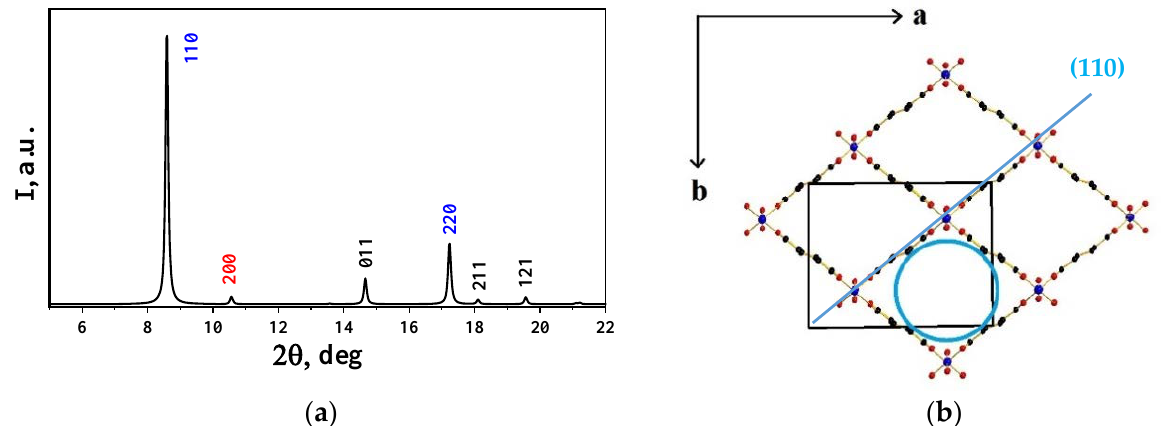
Figure 2. Structure II (sp.gr. I mcm, z = 4): theoretical diffraction pattern ( a ), structure projected onto the ( b ) XY plane.